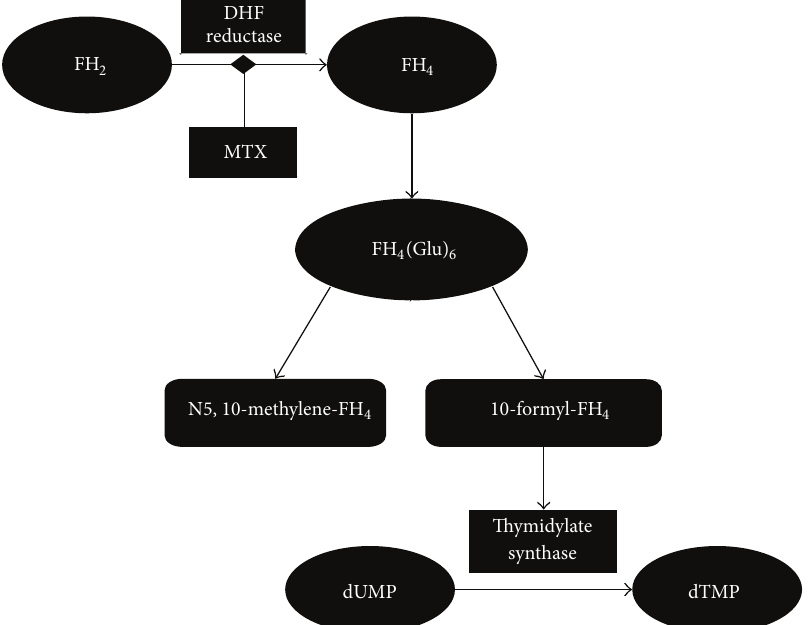
Figure 1: Schematic representation of methotrexate’s pharmacodynamic. Methotrexate (MTX) indirectly blocks the formation of dTMP by inhibiting DHF reductase. FH 2 , which accumulates following the inhibition of DHF reductase, in turn inhibits thymidylate synthase. DHF = dihydrofolate; FH 2 = dihydrofolic acid; FH 4 = tetrahydrofolic acid; dTMP = thymidine monophosphate; and dUMP = deoxyuridine